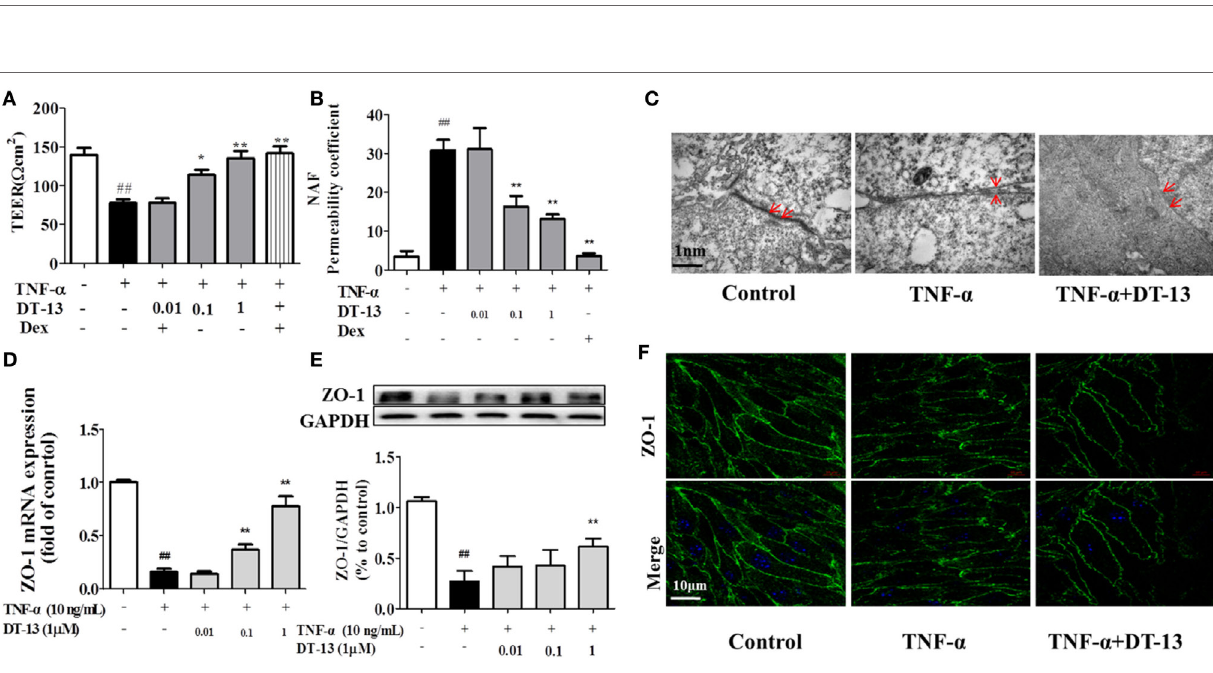
FigUre 2 | DT-13 ameliorated TNF- α -induced endothelial hyperpermeability. (a) EC permeability was measured using a Millicell-ERS voltohmeter. Human umbilical vein endothelial cells (HUVECs) were pretreated with various concentrations of DT-13 (0.01, 0.1, and 1 µM) or dexamethasone (1 µM) for 1 h followed by TNF- α (10 ng/mL) stimulation for 4 h. (B) The transendothelial permeability was assessed using the paracellular transport marker (sodium fluorescein) permeability coefficient, which was measured using a fluorescence multiwall plate reader [Ex ( λ ) 485 nm; Em ( λ ) 530 nm]. (c) Ultrastructural characteristics of tight junctions (TJs) (magnification × 50,000). TJs were intact in the group control; TJs were disrupted in the TNF- α -induced group; TJs were not disrupted in HUVECs pretreated with DT-13 (1 µM). (D) The mRNA level of ZO-1 was determined by real-time PCR. High-dose and moderate-dose DT-13 groups showed increases in the mRNA level of ZO-1 following TNF- α treatment. (e) Western blotting analysis revealed the effects of high-dose DT-13 on the protein expression of ZO-1, whereas the moderate- dose DT-13 group exhibited no significant change. (F) ZO-1 localization within the TJs of endothelial cells is altered by TNF- α , which was inhibited by DT-13. The ZO-1 in green and the DAPI in blue. Bar = 50 μ m. The data represent the mean ± SD from three experiments. ## P < 0.01 vs. the control group; * P < 0.05, ** P < 0.01 vs. the TNF- α